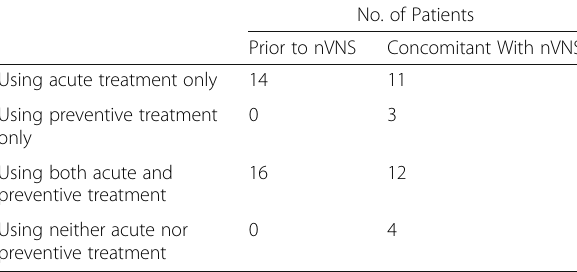
Abbreviation: nVNS non-invasive vagus nerve stimulation